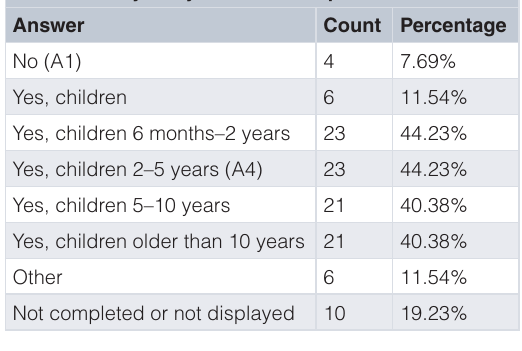
Table 2. Designing a clinical trial in sickle cell disease. Would you be willing to randomly assign young children to hydroxycarbamide or placebo in a